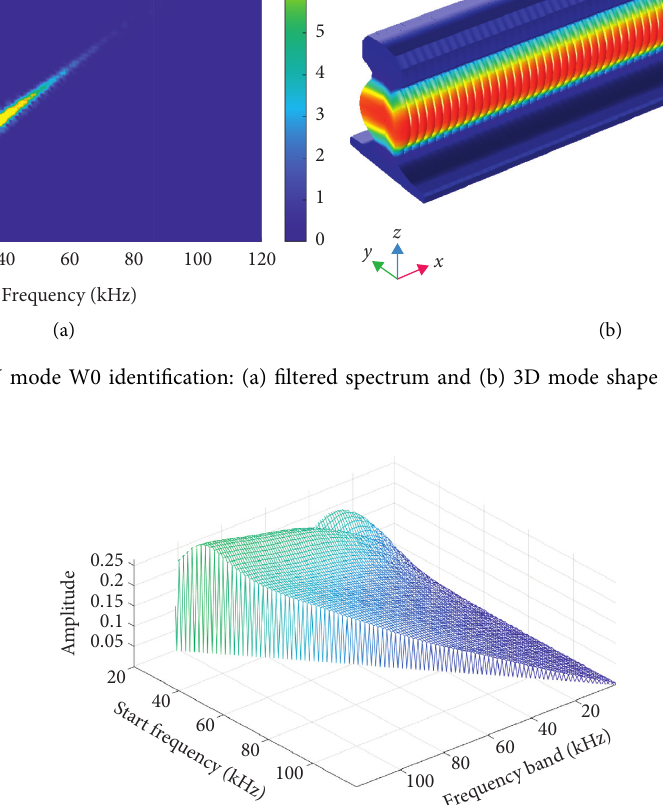
Figure 9: Reconstructed amplitude with sweeping frequency band.